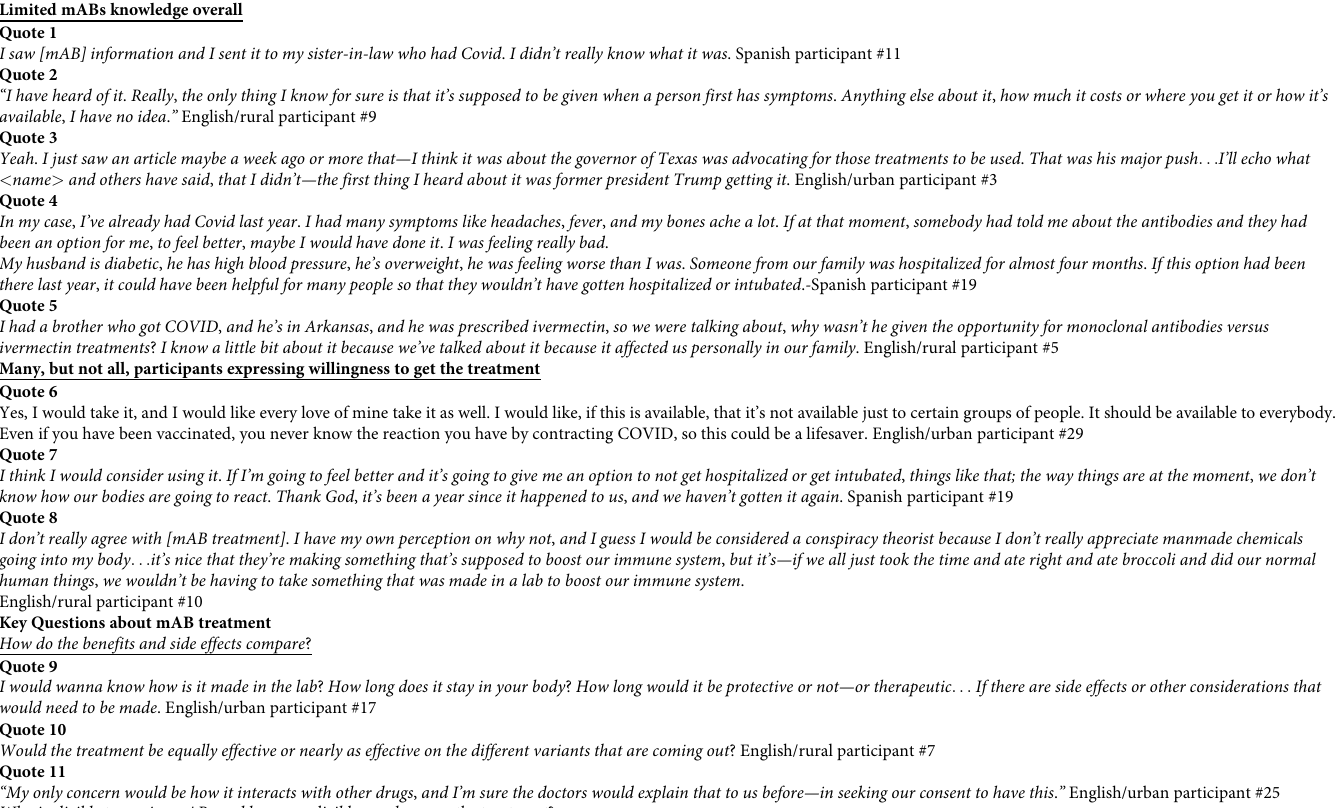
Table 5. Illustrative quotes for qualitative analysis of focus group themes. Limited mABs knowledge overall Quote